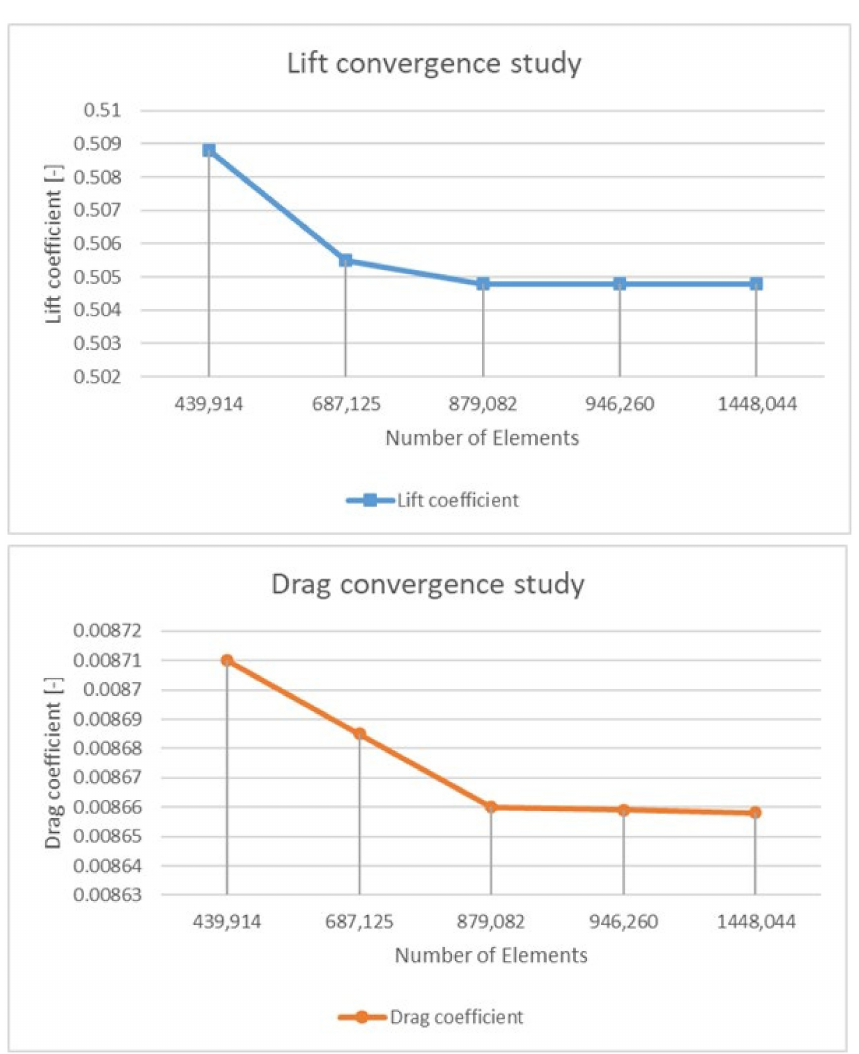
Figure 3. Aerodynamic coefficients vs. number of